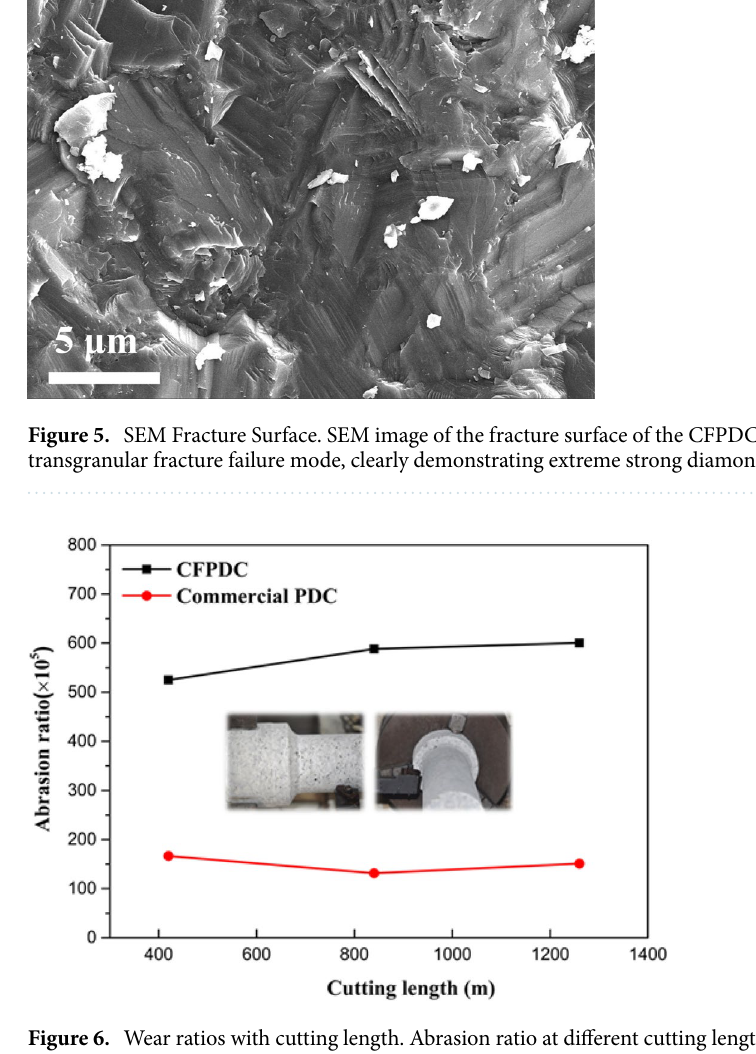
Figure 6. Wear ratios with cutting length. Abrasion ratio at different cutting lengths for commercial PDC and CFPDC samples, and inset is the optical picture to show the turning experiment set